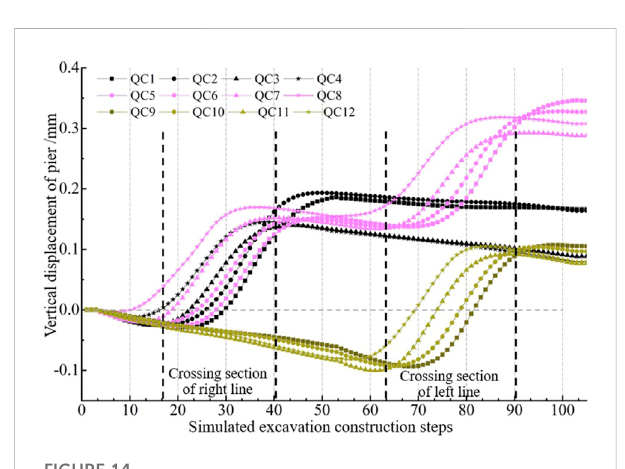
FIGURE 14 Variationsinthedisplacementofbridgepiermeasurementpoints (numerical